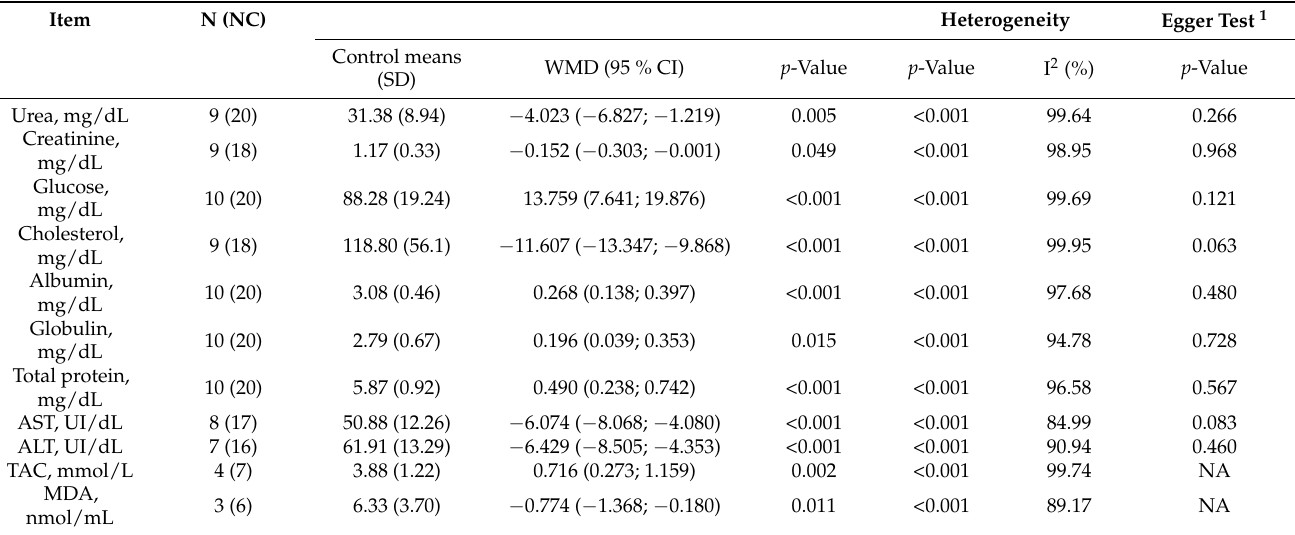
Table 4. Serum metabolites of rabbits supplemented with bee pollen.